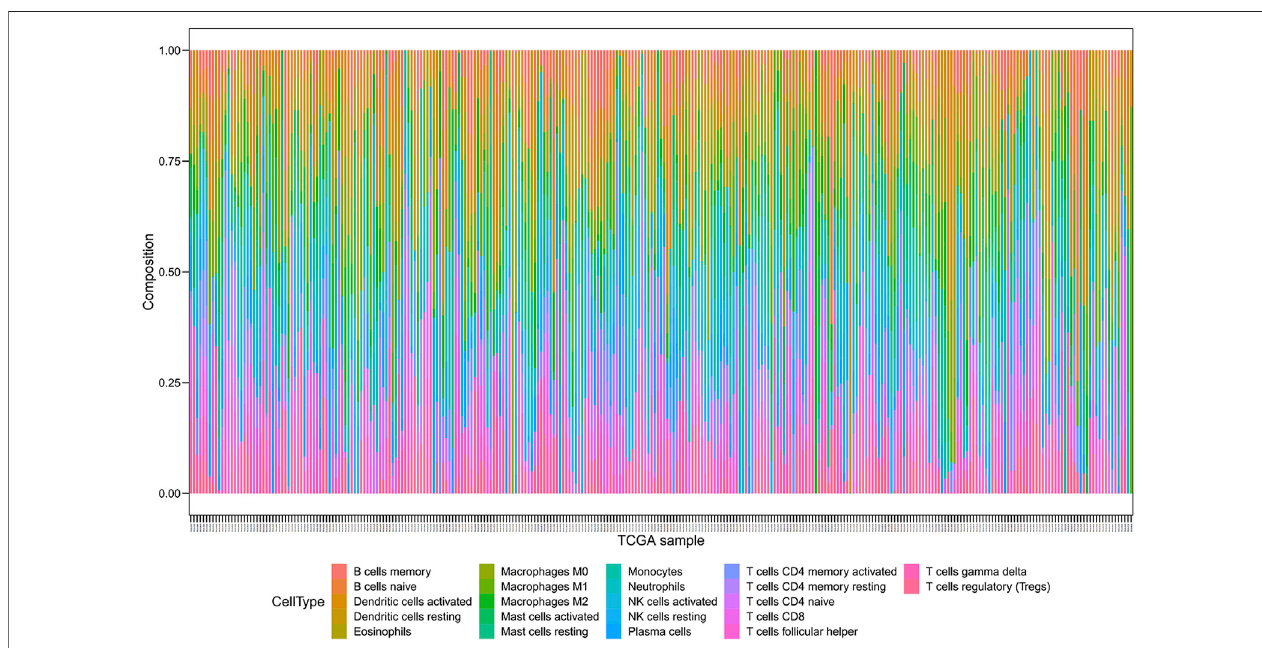
FIGURE 7 | Composition of immune cells were evaluated through the CIBERSORT algorithm, and 22 immune cells were annotated with different colors in the legend.